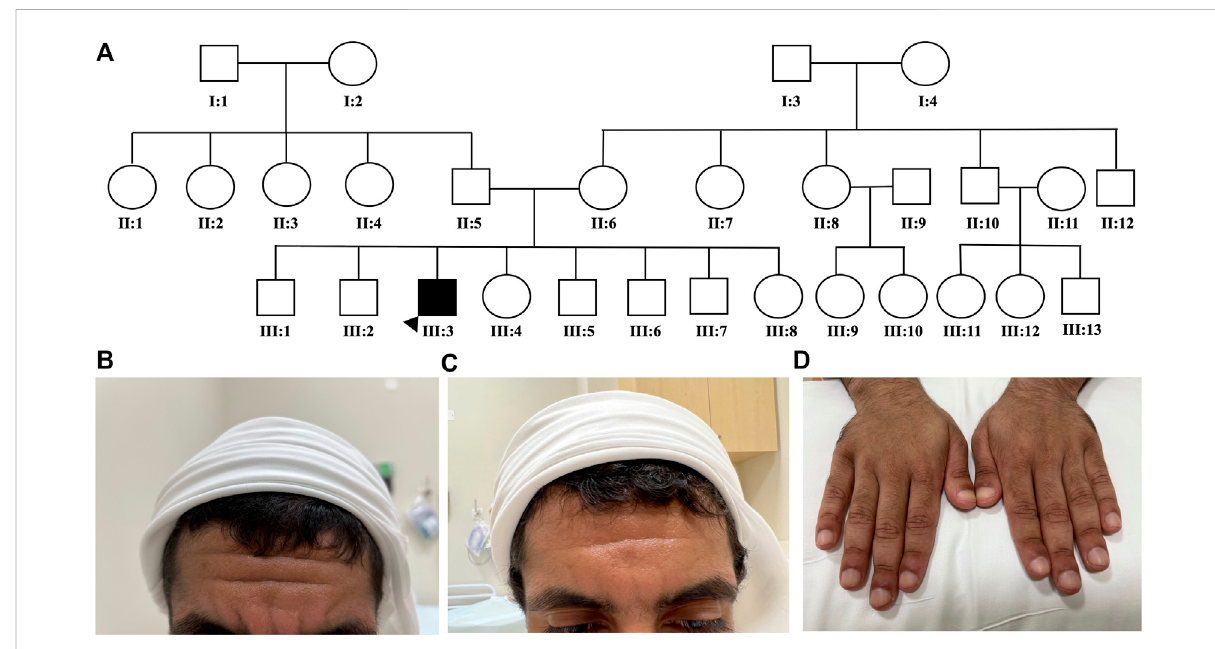
FIGURE 1 Patients ’ family pedigree and characteristics. Patient ’ s family pedigree showing a negative history of similar conditions (A) . Severity of patient ’ s forehead furrowing is shown before (B) , and after (C) etoricoxib treatment. A signi fi cant improvement in digital clubbing after etoricoxib treatment was observed (D)